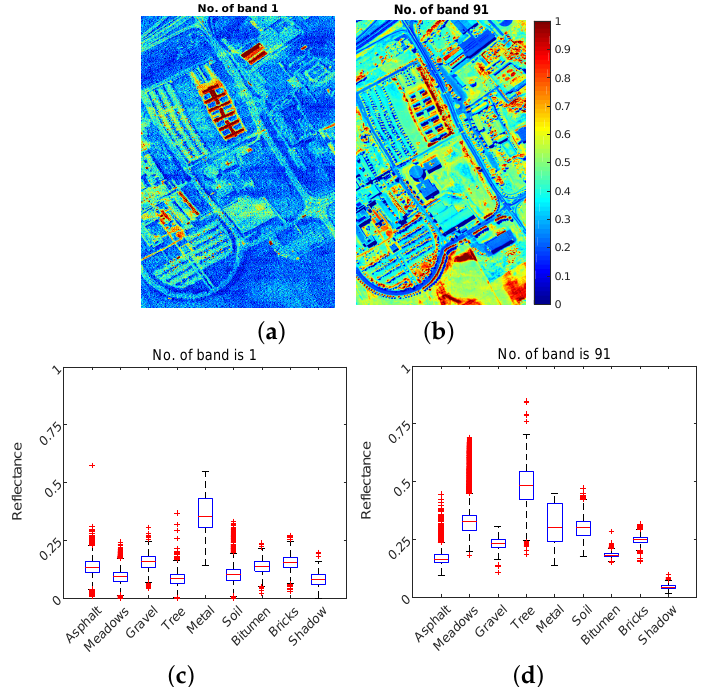
Figure 4. Band No. 1 ( a ) and No. 91 ( b ) with corresponding box plot analysis ( c , d